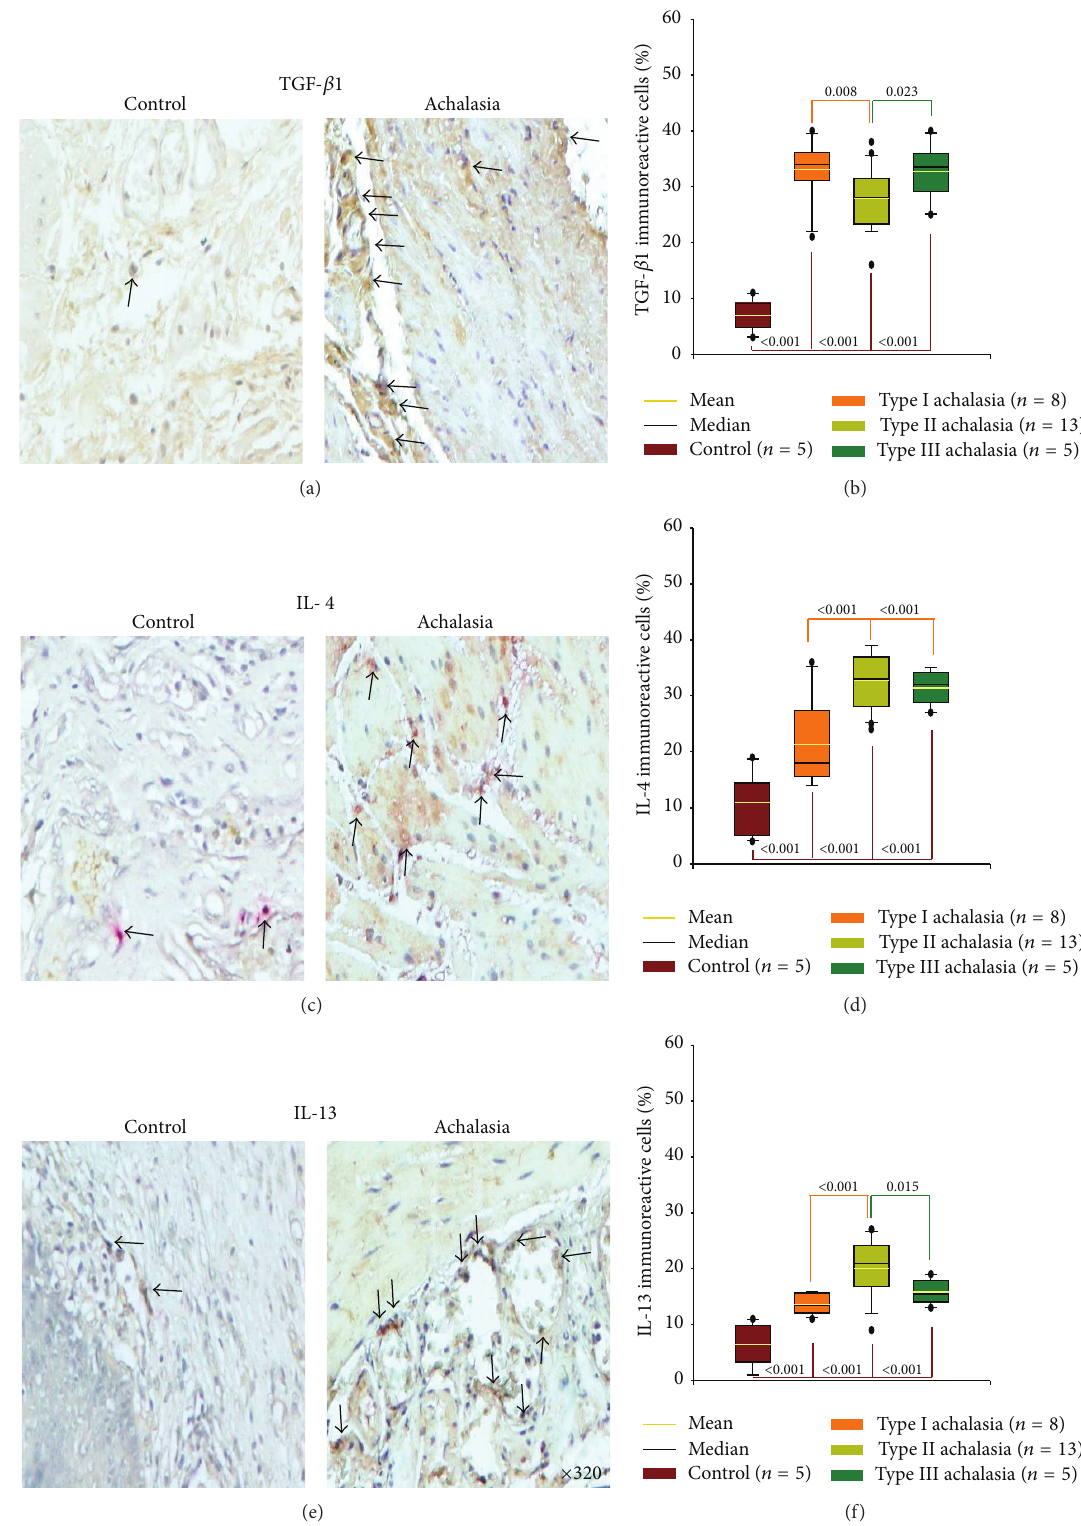
Figure 3: Anti-inflammatory/profibrogenic cytokine expression in achalasia. Immunohistochemistry for (a) TGF- 𝛽 1, (c) IL-4, and (e) IL-13 cells in control and achalasia sections. Arrows depict immunoreactive cells. Original magnification was × 320. Results are expressed as mean (yellow line), median (black line), and 5th/95th percentiles of (b) TGF- 𝛽 1 + , (d) IL-4 + , and (f) IL-13 +